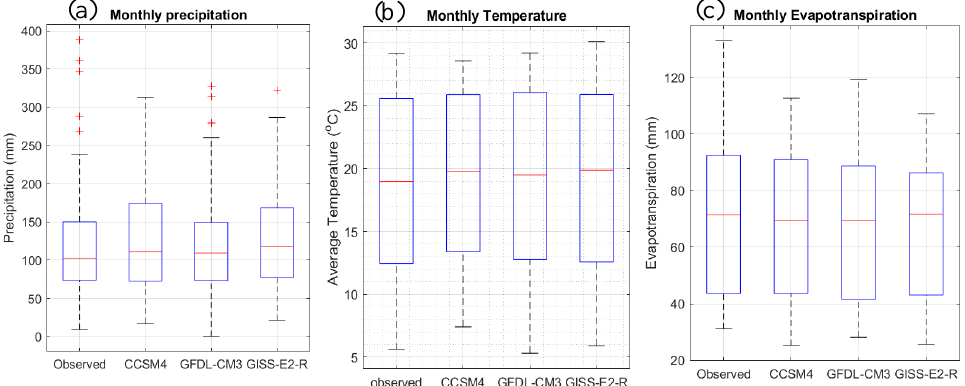
Figure 3. Comparing General Climate Models (GCMs) results to the observed values.